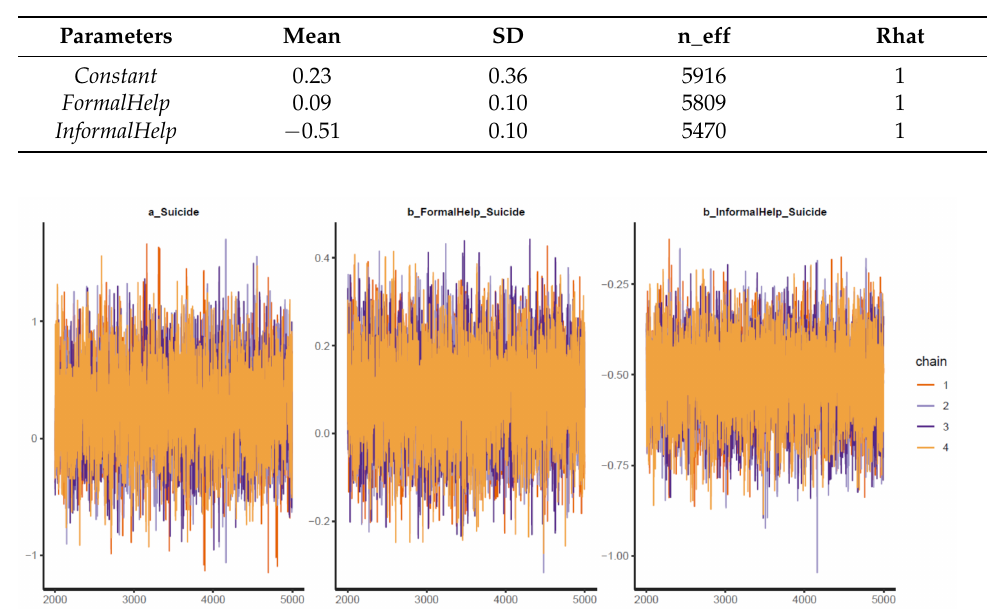
Table 5. Model 4 (cid:48) s simulated posteriors.